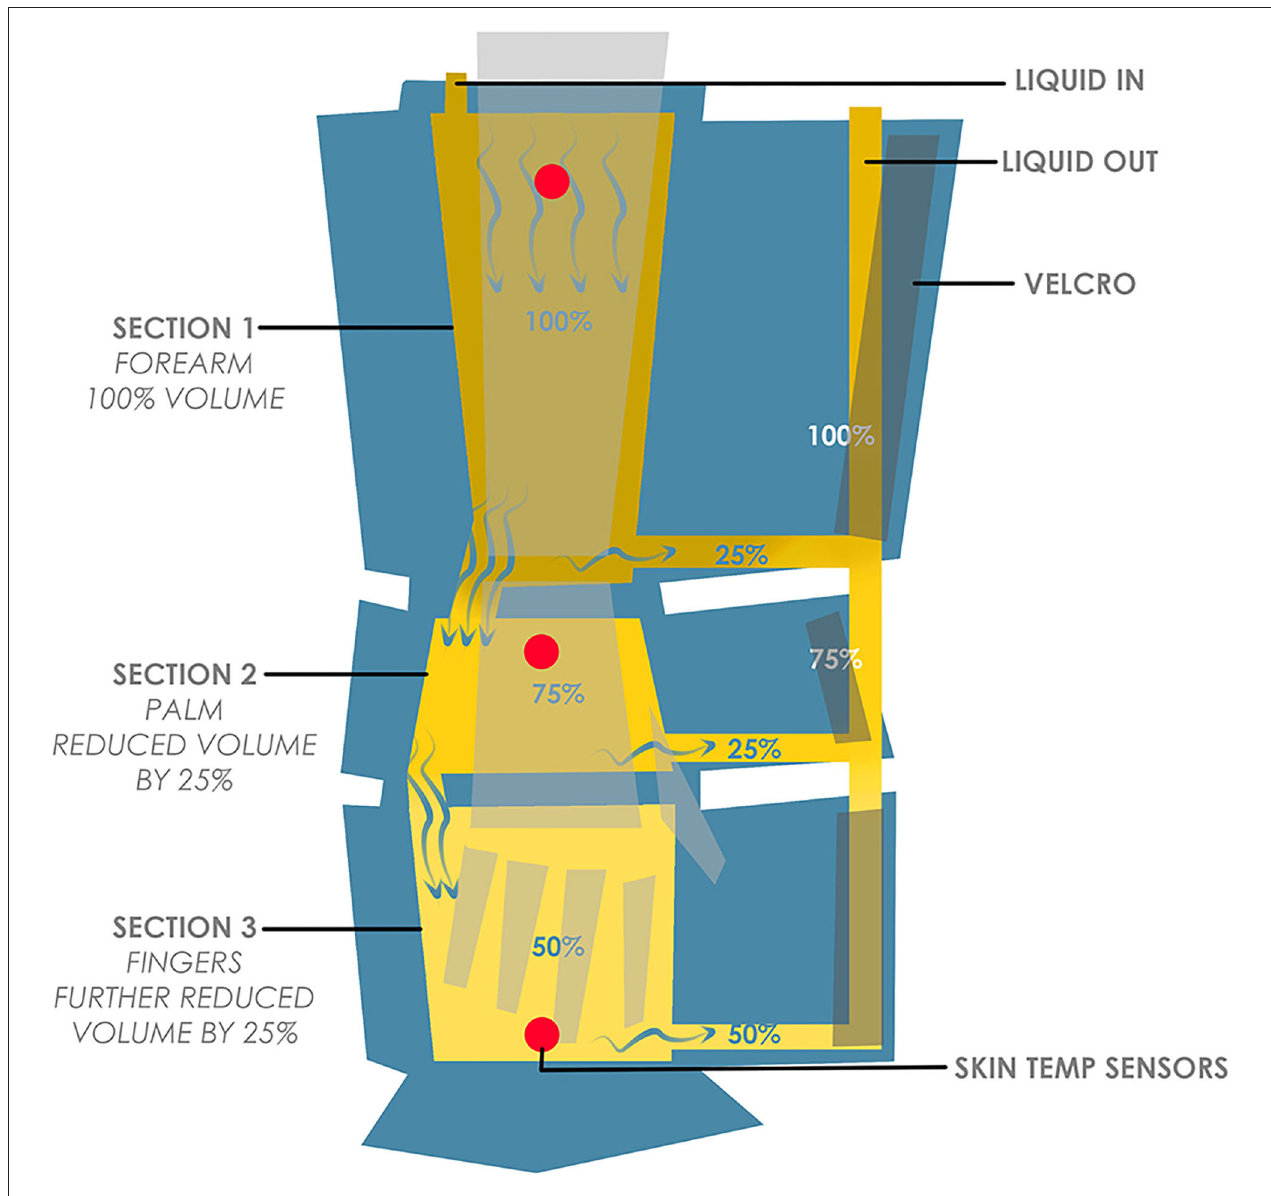
FIGURE 5 | Bottleneck temperature regulation arm wrap